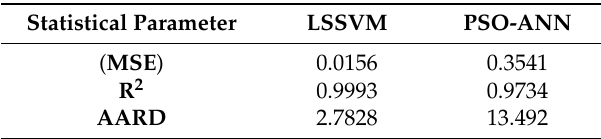
Figure 14. Comparison between PSO ‐ ANN outputs and experimental viscosity of (cid:1832)(cid:1857) (cid:2870) (cid:1841) (cid:2871) /ethylene glycol ‐ water nanofluid, versus volume fraction (%) at different condition.